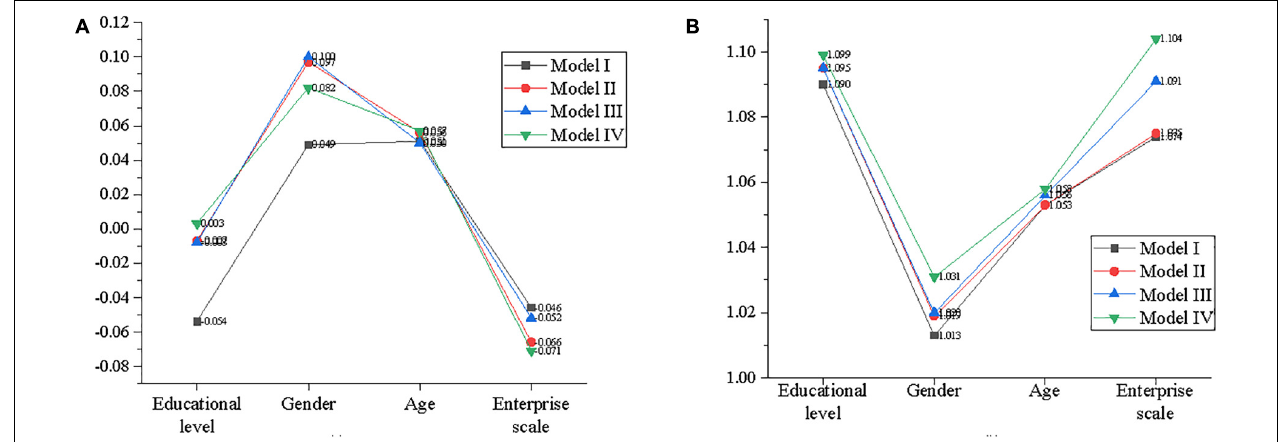
FIGURE 11 | Regression analysis of the moderating effect of normative commitment on model innovation and entrepreneurial behavior. (A) Beta value, (B) variance inflation factor (VIF) value.